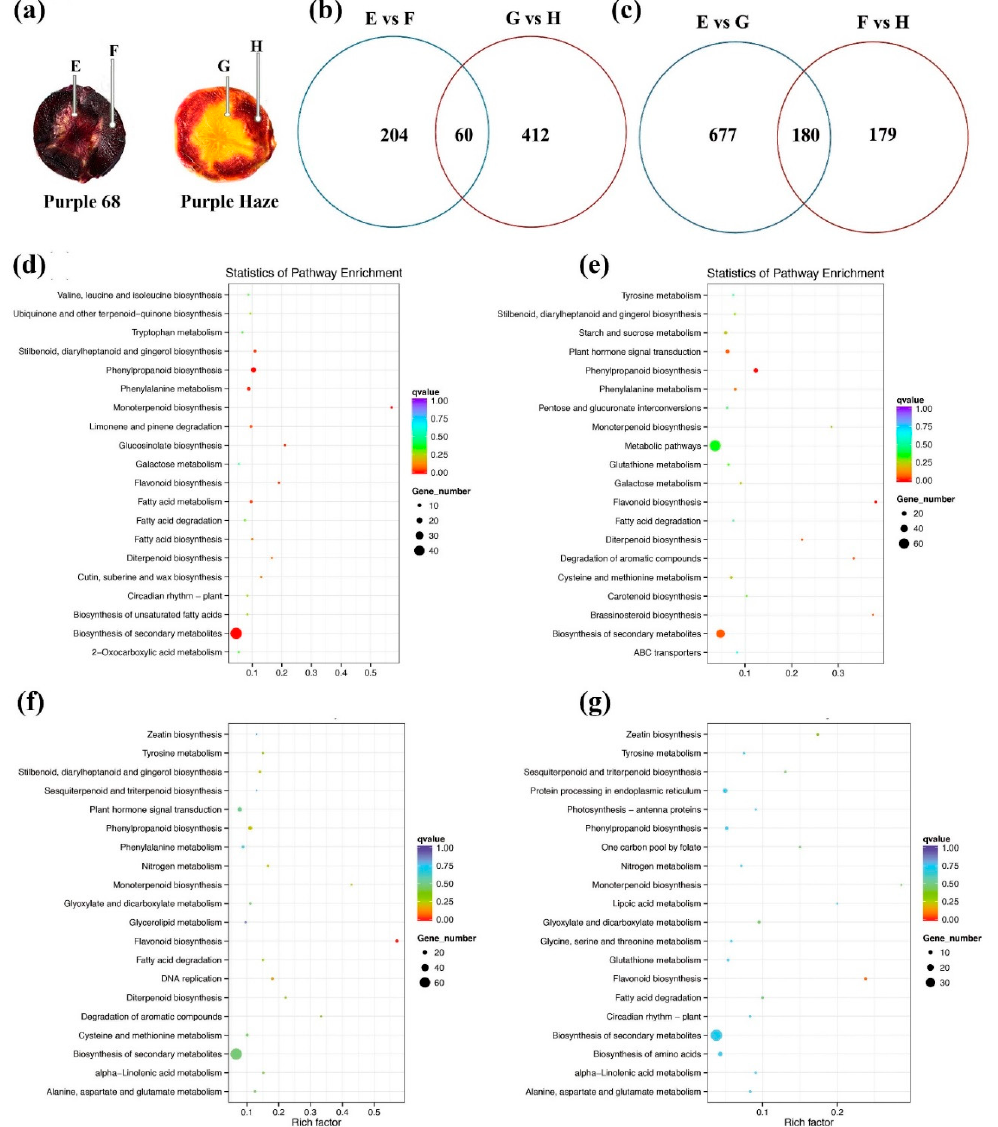
Figure 2. KEGG pathway analysis of different of carrots tissues ( a ) Phloem and xylem tissue in ‘Purple 68 ′ and ‘Purple Haze’. ( b ) Venn diagram of DEGs in the comparison of E vs. F and G vs. H. ( c ) Venn diagram of DEGs in the comparison of E vs. G and F vs. H. ( d ) ( e ) ( f ) ( g ) Scatterplot of the top 20 enriched KEGG pathways of E vs. F, G vs. H, E vs. G and F vs. H, respectively. Rich factor is the ratio of DEGs counts to this pathway in the annotated genes counts. q ≤ 0.05 indicates significant enrichment. E (xylem of ‘Purple 68 ′ ), F (phloem of ‘Purple 68 ′ ), G (xylem of ‘Purple Haze’), and H (phloem of ‘Purple Haze’).